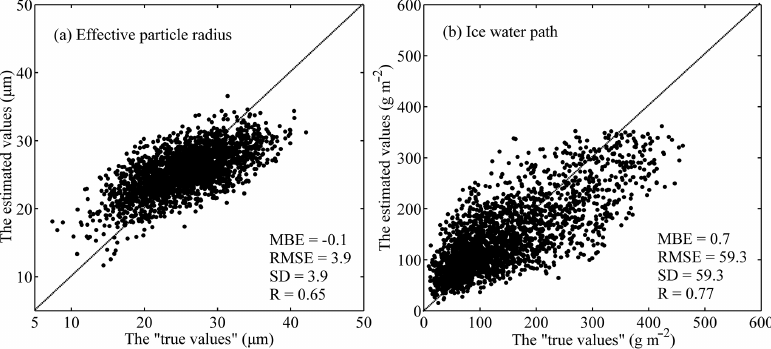
Figure 4. Same as Fig. 3 but for ice